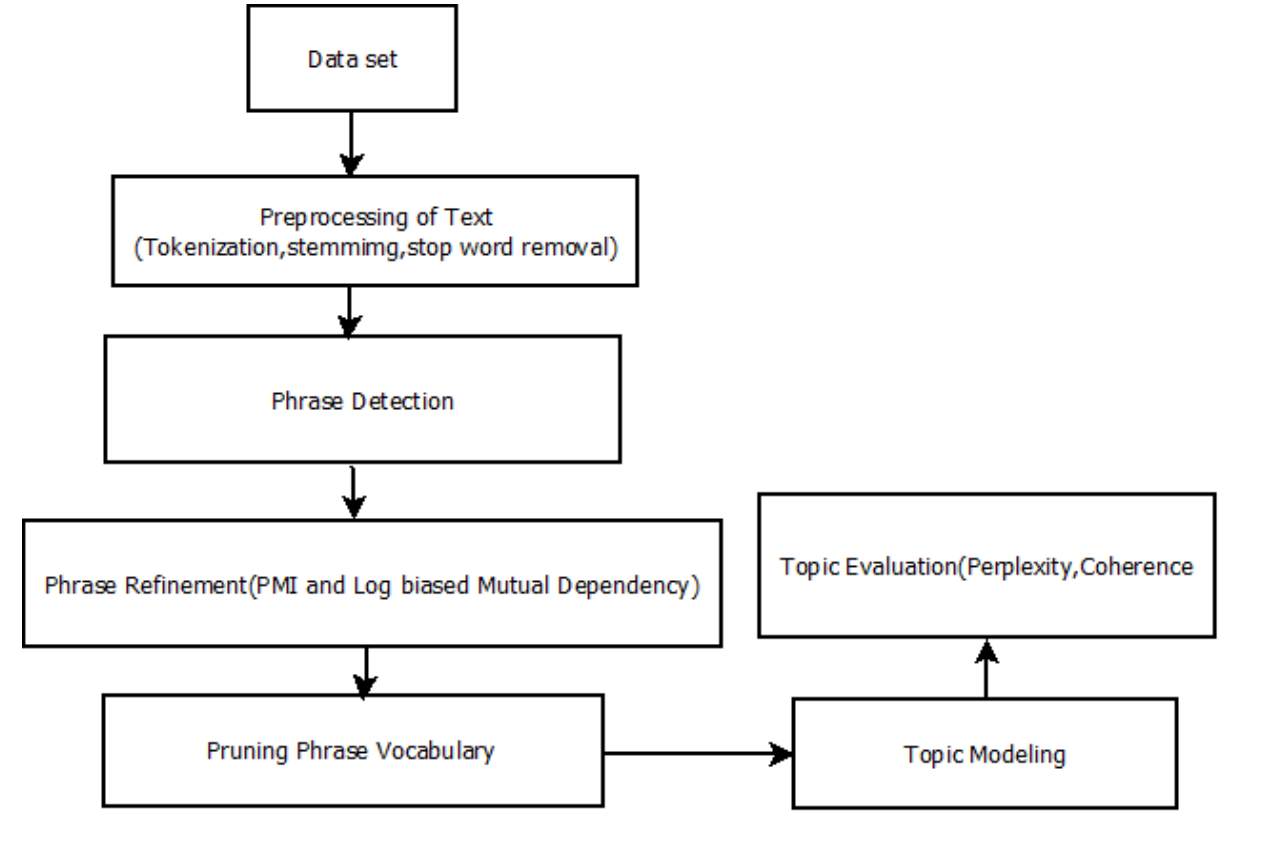
Figure 1. Proposed Semantic N-Gram Topic Modeling (SNTM)